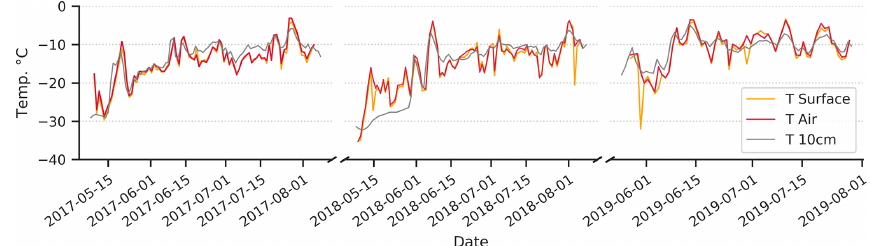
Figure A6. Daily mean 2m air temperature (red), surface temperature (yellow) and 10cm subsurface temperature (grey). The data are presented for the 2017, 2018 and 2019 measurement